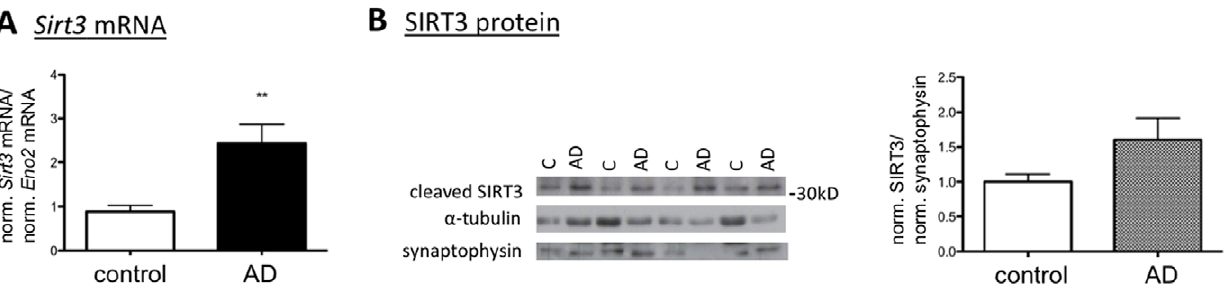
Figure 4. Sirt3 is upregulated in human Alzheimer’s disease (AD). A. Sirt3 mRNA expression is significantly increased in AD temporal cortex samples compared to matched controls (n=14, **P , 0.01). Protein and RNA were extracted from neuropathologically confirmed sporadic AD and matched control temporal cortex dissected samples. Sirt3 and Eno2 mRNA were measured and normalized to 18S rRNA using TaqMan multiplex QPCR. B. Cleaved (active) SIRT3 protein is increased in AD temporal cortex samples (n=14 2 15). Protein levels were determined by Western Blot and normalized to a -tubulin and synaptophysin.